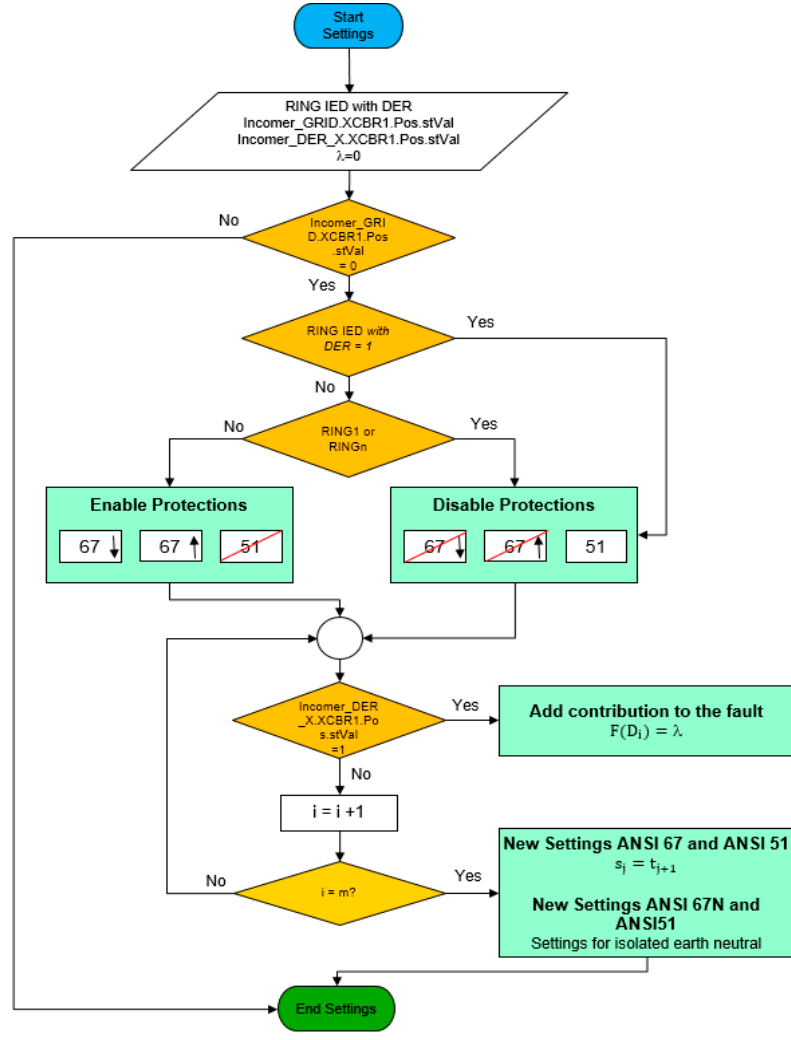
Figure 11. DS (up) and GOOSE Control Block (down) implementation.